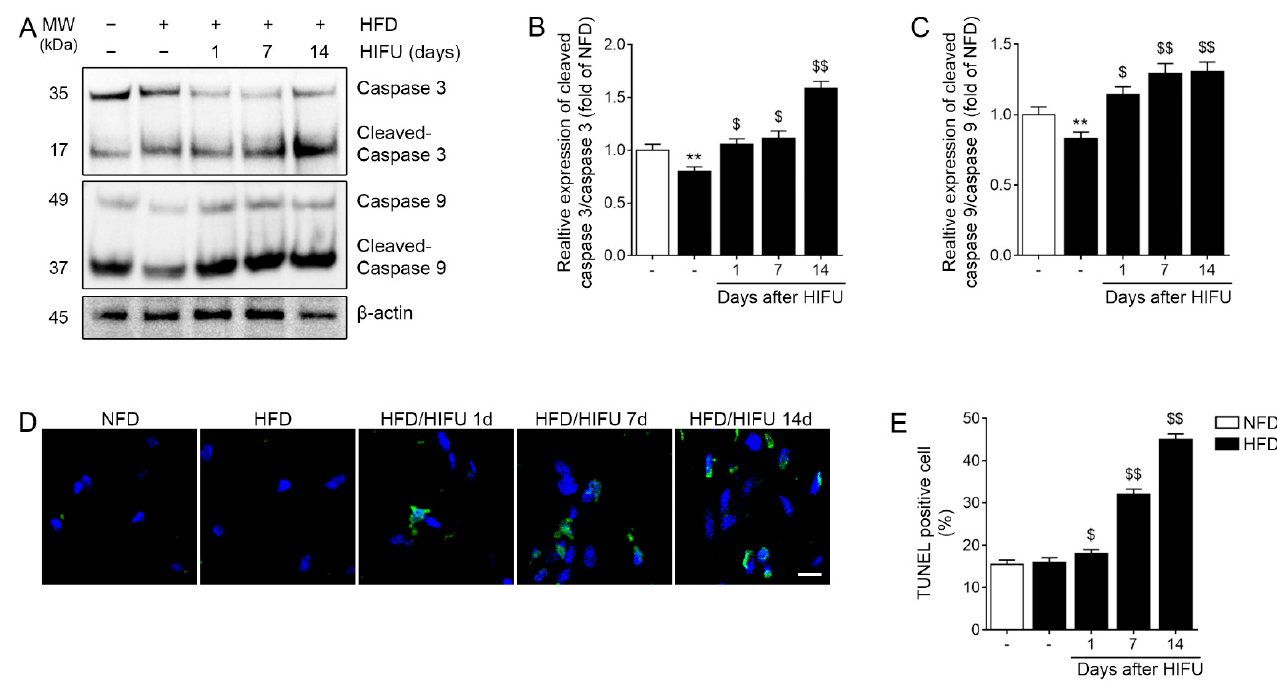
Figure 4. Regulation of apoptosis in SAT by HIFU treatment. ( A ) The protein expression levels of caspase 3 and caspase 9 were analyzed by western blot. ( B , C ) The quantitative graphs represent the results of the western blot analysis. The protein expression ratios of cleaved caspase 3/caspase 3 ( B ) and cleaved caspase 9/caspase 9 ( C ) were increased by HIFU treatment. ( D , E ) The number of apoptotic cells was analyzed by TUNEL assay. The number of apoptotic cells was increased by HIFU treatment. The data are presented as the mean ± standard deviation; **, p < 0.01 HFD vs. NFD; $, p < 0.05 or $$, p < 0.01 vs. HFD (Mann–Whitney U test). HFD, high-fat diet; HIFU, high-intensity focused ultrasound; NFD, normal-fat diet; SAT, subcutaneous adipose tissue; TUNEL, TdT-mediated dUTP Nick-End Labeling.